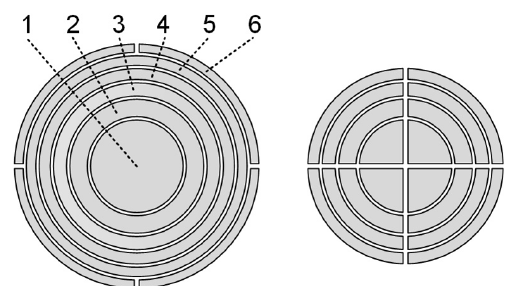
Figure 1. Geometry of the annular arrays: the numbering used in the following paragraphs starts at one for the central element and ends with six for the fifth ring; e.g. s 16 is the signal emitted from the central element and received at the fifth ring.